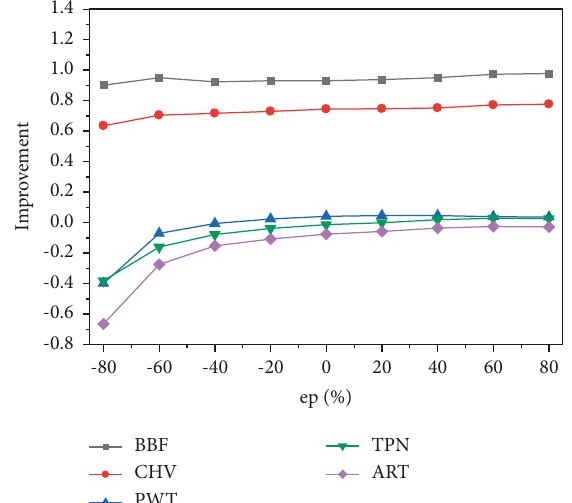
Figure 14: Index improvement under different execution errors